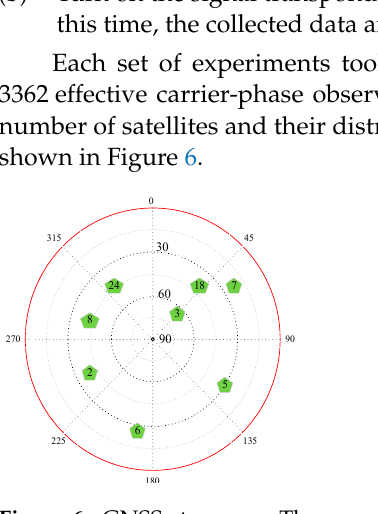
Figure 6. GNSS star map. The green pentagons represent the observed satellite signal, and the number above represents the satellite serial number.